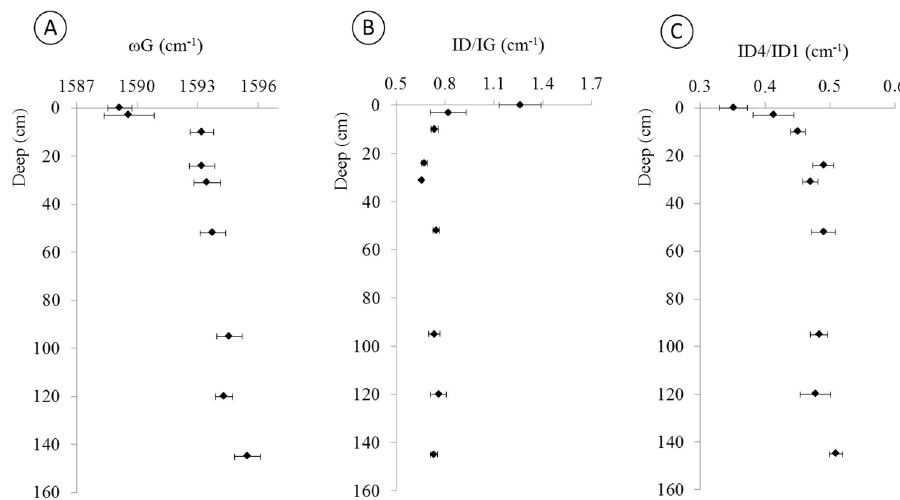
Fig 6. Characteristics of the Raman spectrum distributed along the stratigraphic profile in the following sequence: (A)—frequency of G (cm -1 ); (B)—intensity ratio of ID/IG; and (C)—intensity ratio of ID4/ID1.